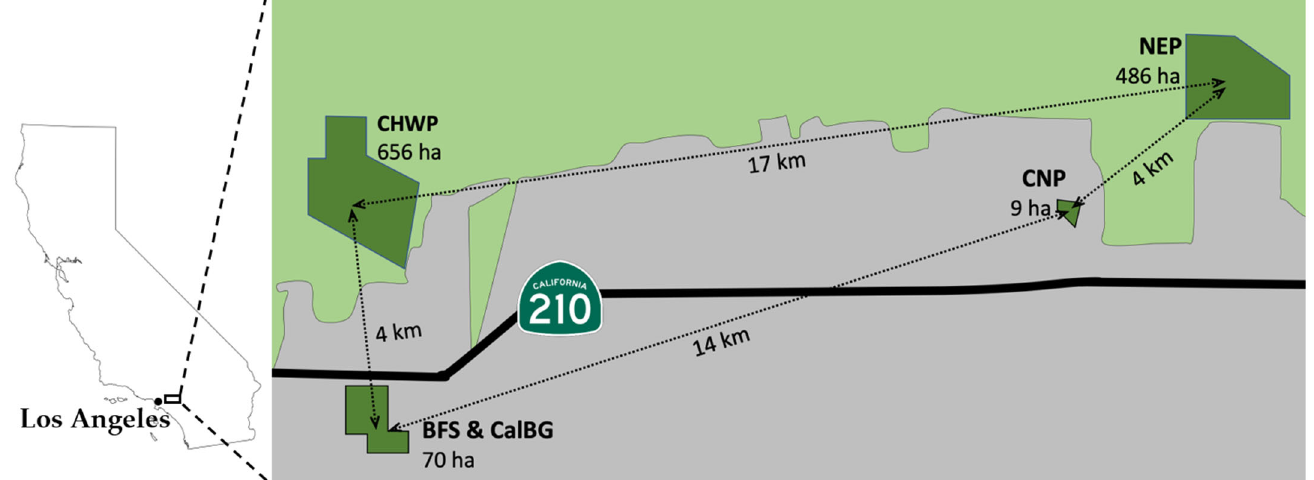
Figure 1. Map of study sites (in dark green) for coyote scat collection. Areas dominated by either native or invasive species are green. Suburbia and mining pits are gray. BFS = Bernard Field Station, CalBG = California Botanic Garden, CHWP = Claremont Hills Wilderness Park, NEP = North Etiwanda Preserve, CNP = Chaffey Nature Preserve.